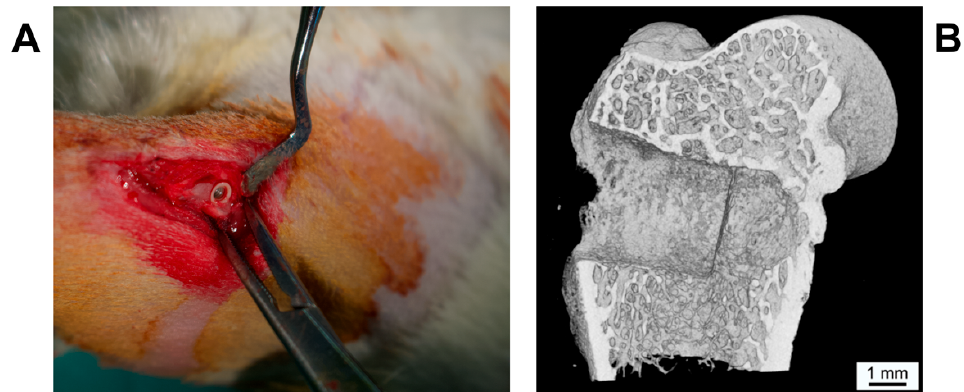
Figure 2. ( A ) Intraoperative picture of inserted implant in lateral aspect of femur. ( B ) µCT image of the bony defect in lateral femur condyle with SiO 2 /HA-coated PEEK implant (SPI), 4 weeks postoperative. The PEEK implant is radiolucent and thus not visible.